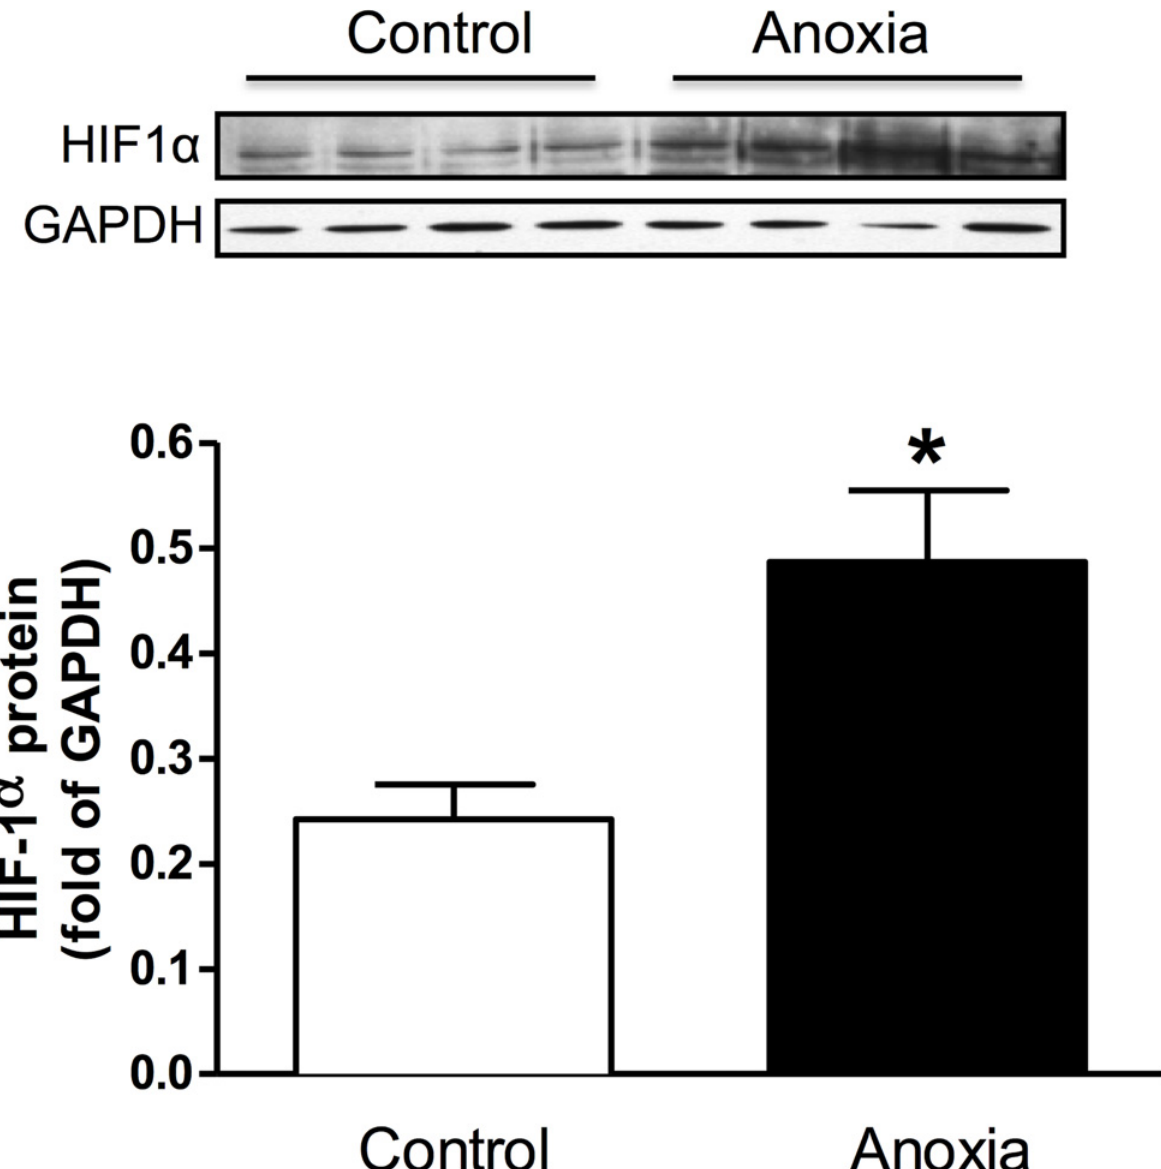
Fig 2. Effect of newborn anoxia on HIF-1 α protein abundance in the neonatal heart. Hearts were isolated from day 4 neonatal rats treated with control or anoxia. Protein abundance of HIF-1 α was determined by Western immunoblotting. Data are means ± SEM. * P < 0.05, anoxia vs . control. n =